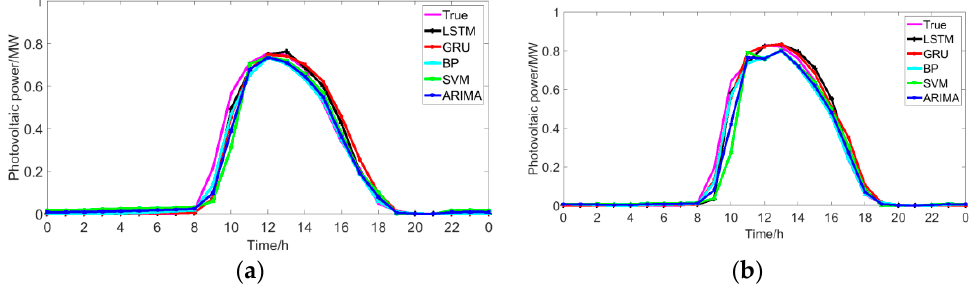
Figure 9. The real photovoltaic power and forecasted photovoltaic power selected from training set randomly. ( a ) Photovoltaic power of 14 May 2013; ( b ) Photovoltaic power of 5 April 2014.